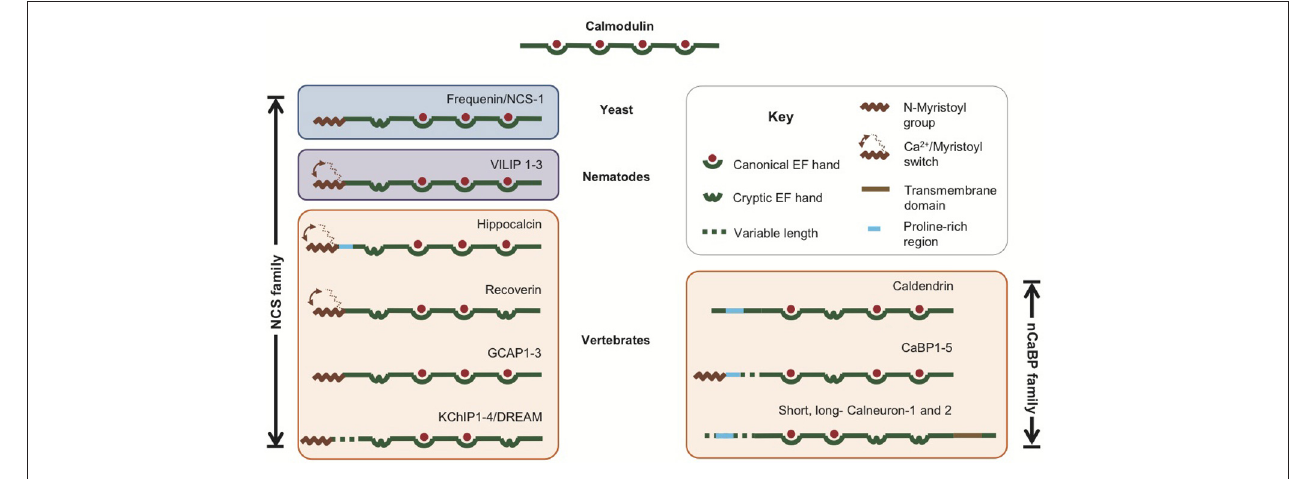
FIGURE 1 | The NCS and nCaBP families of Ca 2 + sensors. A cartoon representation of the different proteins of these families and the various motifs present in them are shown. The proteins